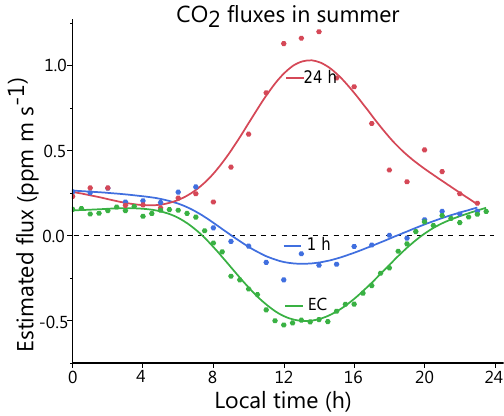
Figure 2. A comparison of measured fluxes using the modified Bowen ratio (MBR) method (1 and 24h pooled data using hourly K heat values) with the eddy covariance (EC) measurements. The simulated 24h sampling time includes a change in the direction of the CO 2 flux, which results in a measured flux with the MBR method that has the wrong direction and